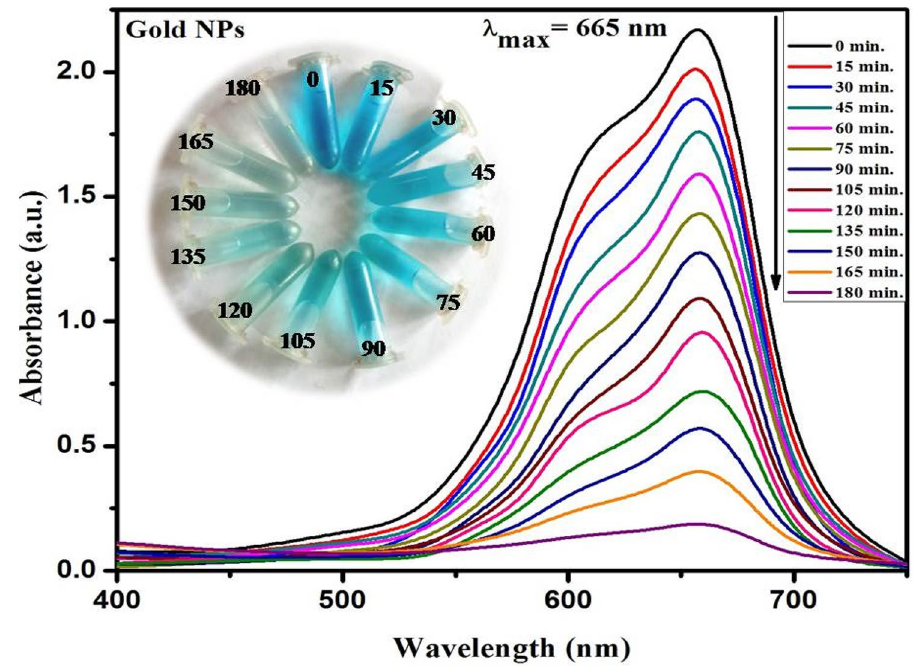
Figure 9. UV–Vis absorption spectra of methylene blue dye using AuNPs.